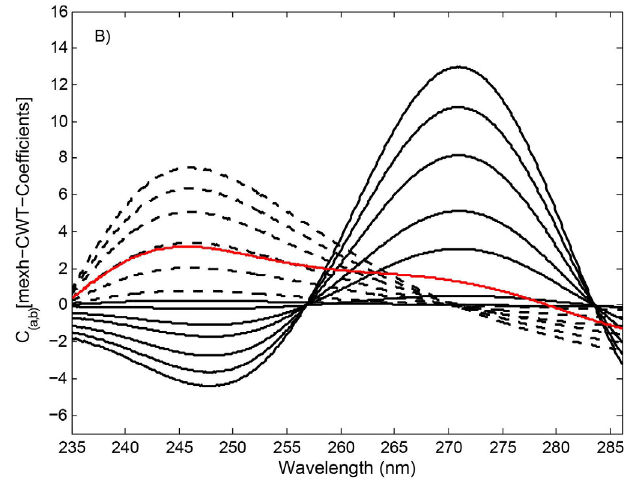
FIGURE 2A - db7-CWT spectra of VAL (----) : 1.0, 3.0, 9.0, 15.0, 21.0, 27.0, 33.0 µ g/mL and HCT (  ) : 1.0, 6.0, 11.0, 16.0, 21.0, 26.0 µ g/mL and tablet sample (  ) containing 2.50 µ g/mL of VAL and 16.0 µ g/mL of HCT .